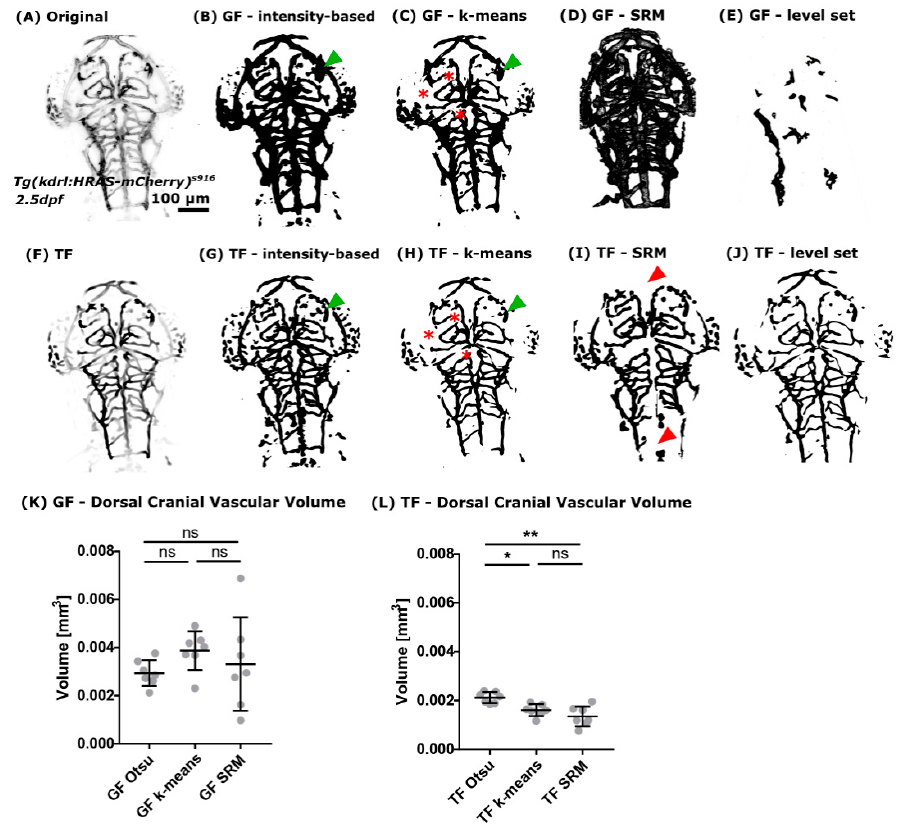
Figure 5. ( A ) Readily implemented segmentation methods of the Fiji image analysis software were applied to images after pre-processing using GF. ( B ) It was found that intensity-based Otsu-thresholding delivered the most robust results in comparison to other methods, such as k-means clustering (( C ); red asterisks: vessels not extracted), SRM ( D ), or fast-marching level set ( E ). ( F ) The same segmentation methods were applied to images after vessel enhancement with TF. Again, it was found that intensity-based Otsu-thresholding delivered the most reliable results ( G ). While k-means clustering ( H ), SRM ( I ), and the tested fast-marching level set implementation ( J ) resulted in an unsatisfactory segmentation. ( K ) Vascular volume quantification after GF showed no statistically significant difference between the tested segmentation methods. ( L ) Quantification of the vascular volume after TF showed a statistically significant difference between the assessed segmentation methods. Namely, TF Otsu vs. TF k-means p 0.0293, TF Otsu vs. TF SRM 0.0058, and TF k-means vs. TF SRM p > 0.9999. CoV was found to be lower after TF with 15.24% k-means and 30.00% SRM and only 10.71% Otsu-thresholding (n = 7, Mann-Whitney U test; representative images).